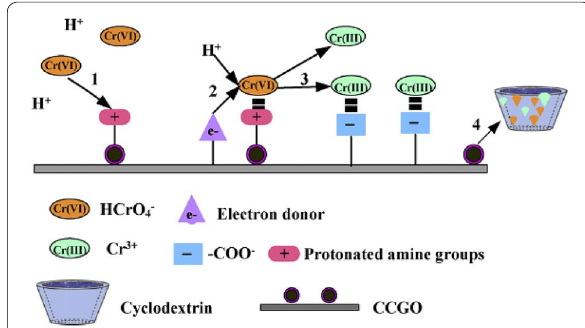
Fig. 11 Removal mechanism of Cr 6 + using cyclodextrin–CTS/GO (CCGO). (Reprinted from [118])